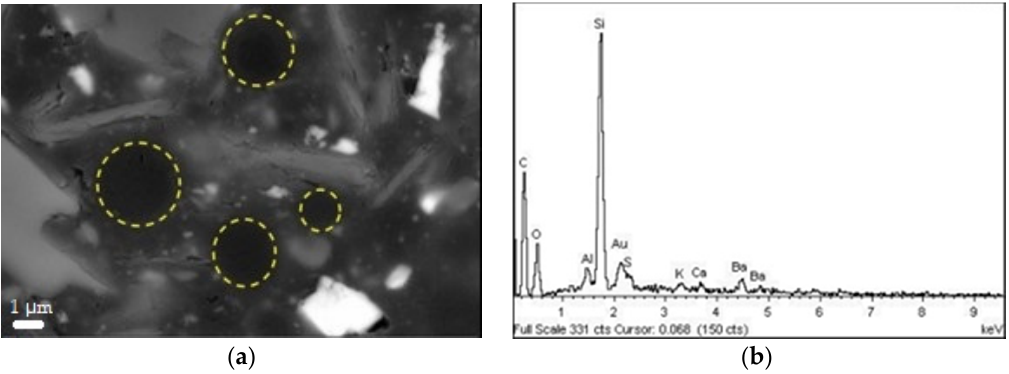
Figure 13. ( a ) SEM-EDS images at high magnification of S6 coating before HT. SEM; and ( b ) EDS analysis of S6 details, highlighted by yellow circles in the SEM image.